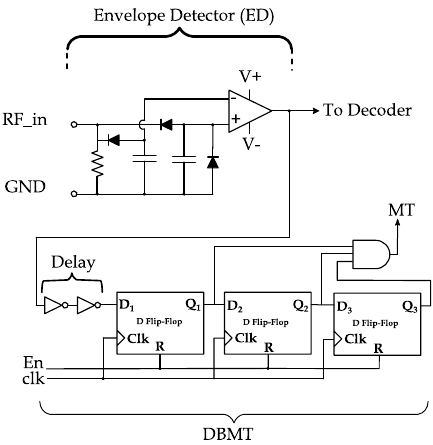
Figure 5. DBMT module and its placement after the ED.